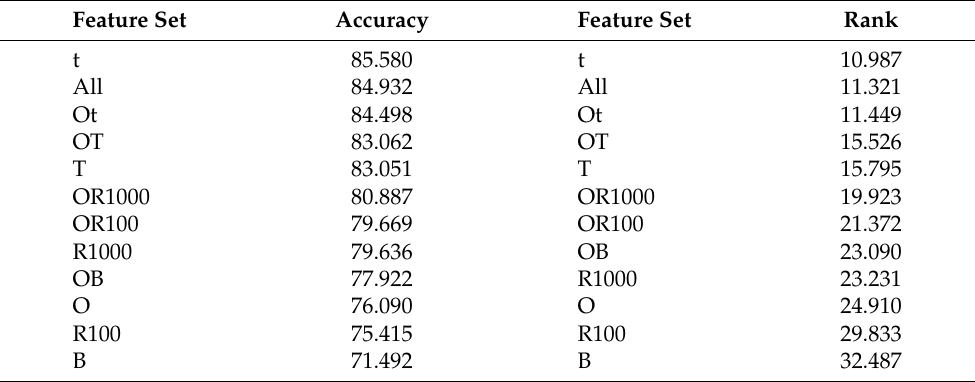
Table 8. Average accuracies and ranks for each feature set, from the difficult datasets. For each feature set, the values in these tables are the averages for RF, SVM-L, and SVM-G in Table